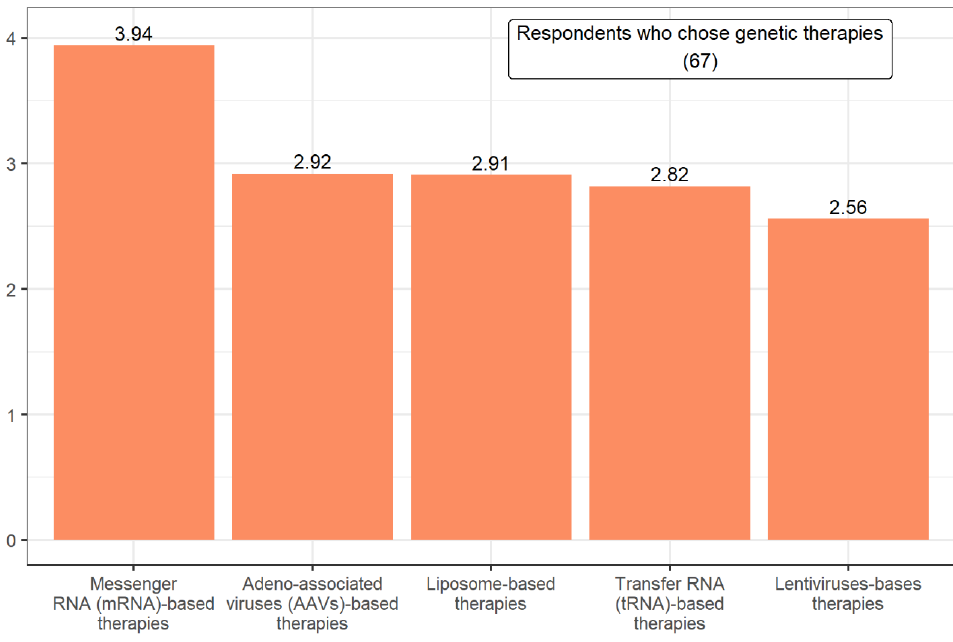
Figure 3. Ranking of genetic-based therapies.